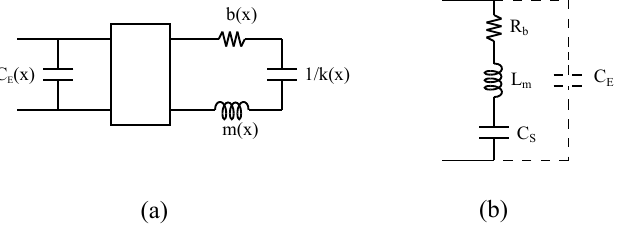
Figure 2. Resonant sensor models. ( a ) general nonlinear model, in this model the lumped element values are characterized by a spatial dependency; ( b ) Butterworth Van Dyke (BvD)